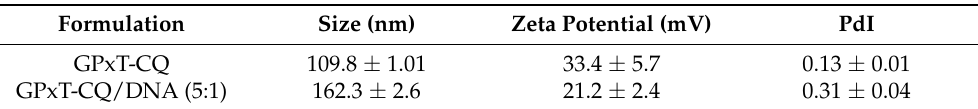
Table 2. Physicochemical characterization of GPxT-CQ cationic niosome and its corresponding nioplex at a cationic lipid:DNA ( w / w ) ratio of 5:1. Each value represents the mean ± SD ( n = 3).